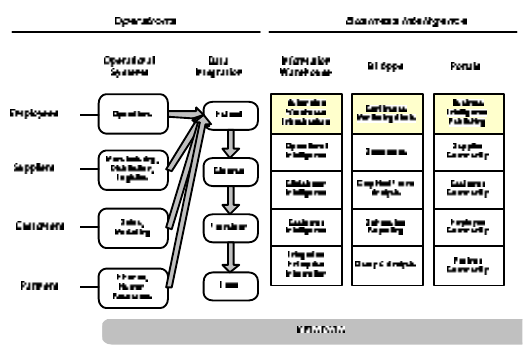
Figure 2 Business Intelligence Infrastructure’s Layers